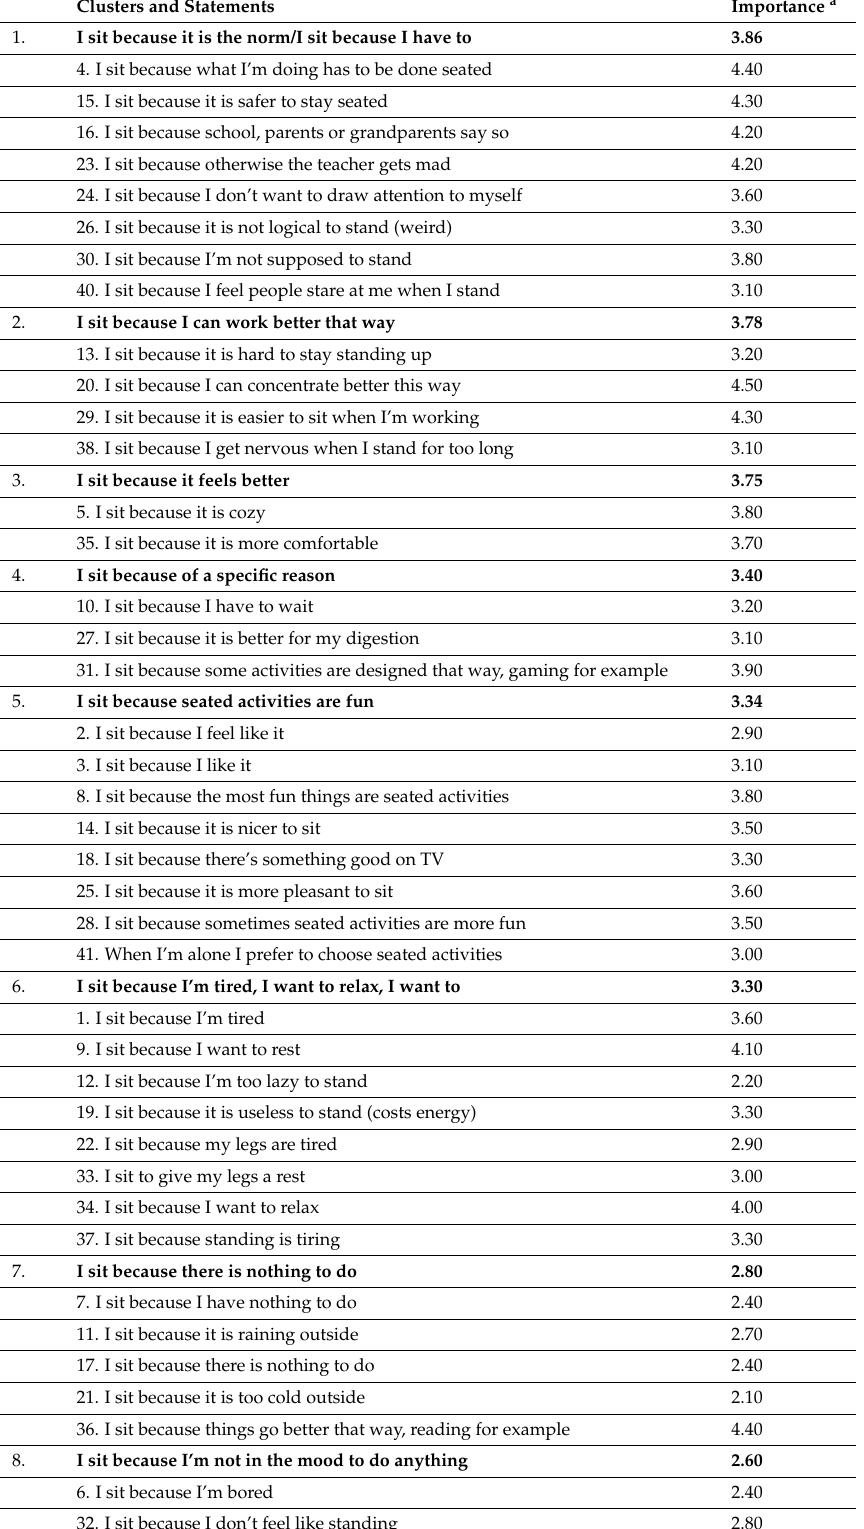
Table A1. Clusters, statements and importance ratings of children (school